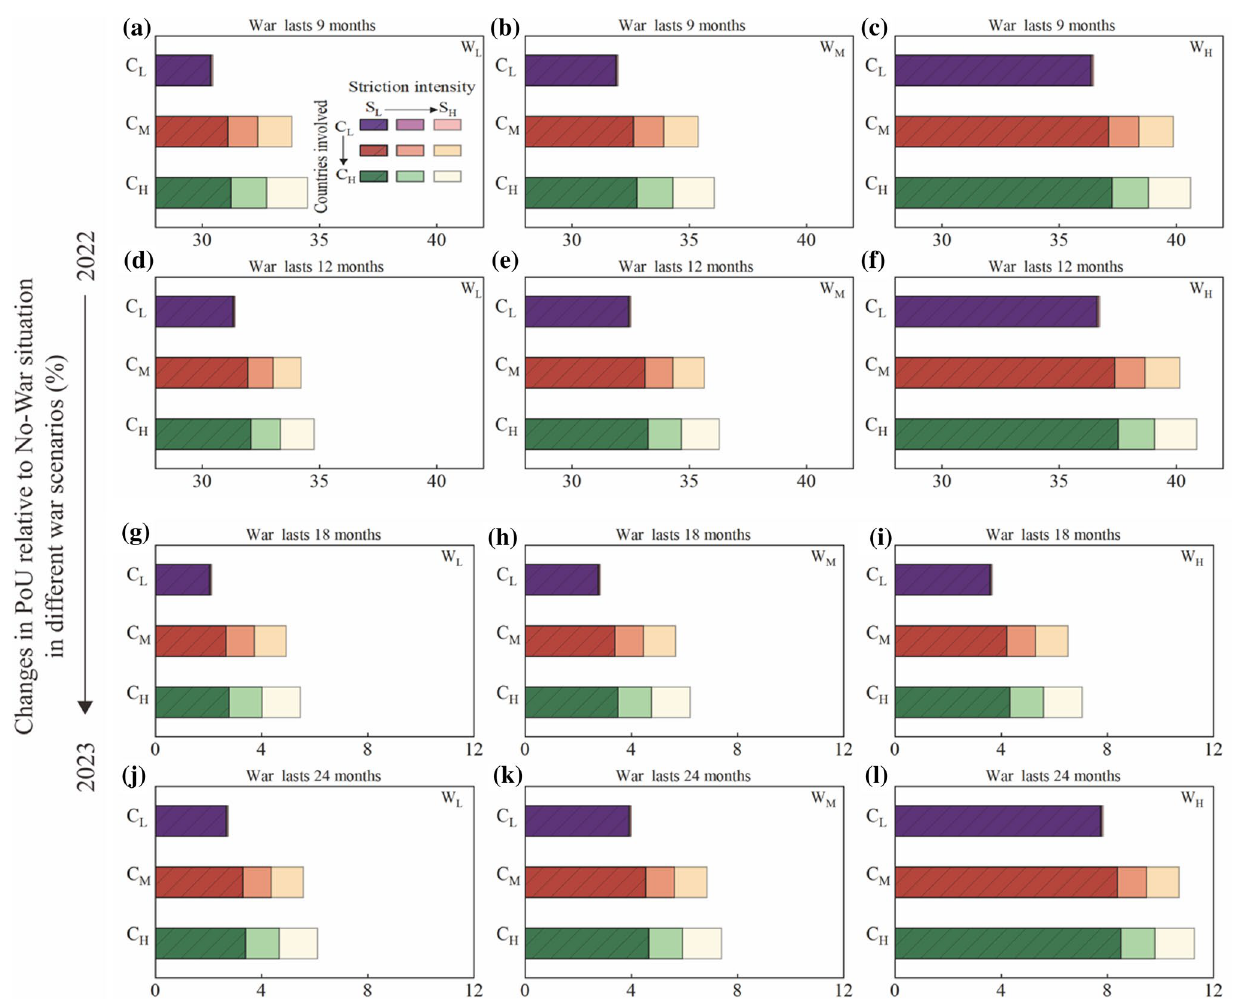
Fig. 3 Growing global PoU along with the duration(T), severity(W), sanction(S) intensity, and the number of countries involved (C). The let- ters L, M and H mean war levels of low, medium, and high. Each bar presents the PoU impacted by one scenario combined with four war fac- tors. A total of 104 scenarios are presented. The panel within a indicates the impact of sanctions on global PoU under the same war situation in different